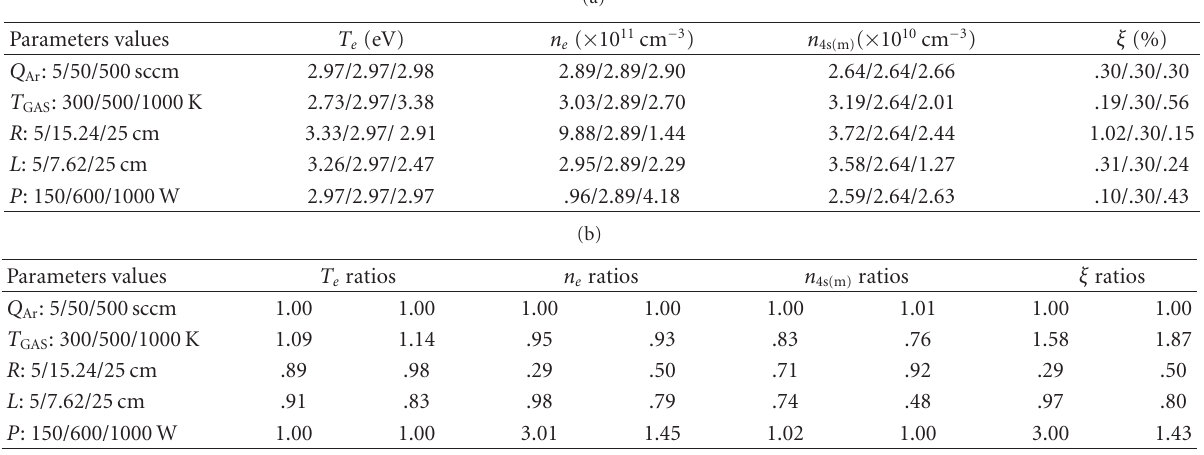
Table 8: As in Table 7 but for a pressure of 5 mTorr.